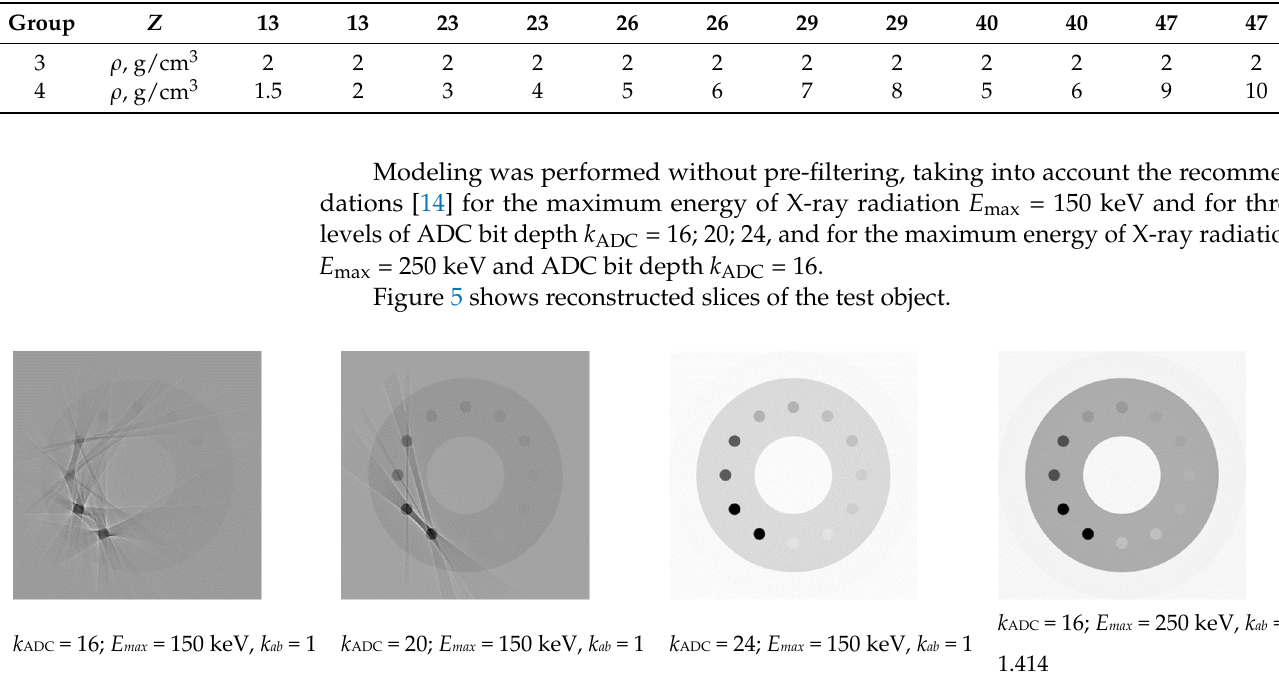
Figure 5. Reconstructed slices of an aluminum cylinder 200 mm in diameter with cylindrical inserts (Table 1, group 3).